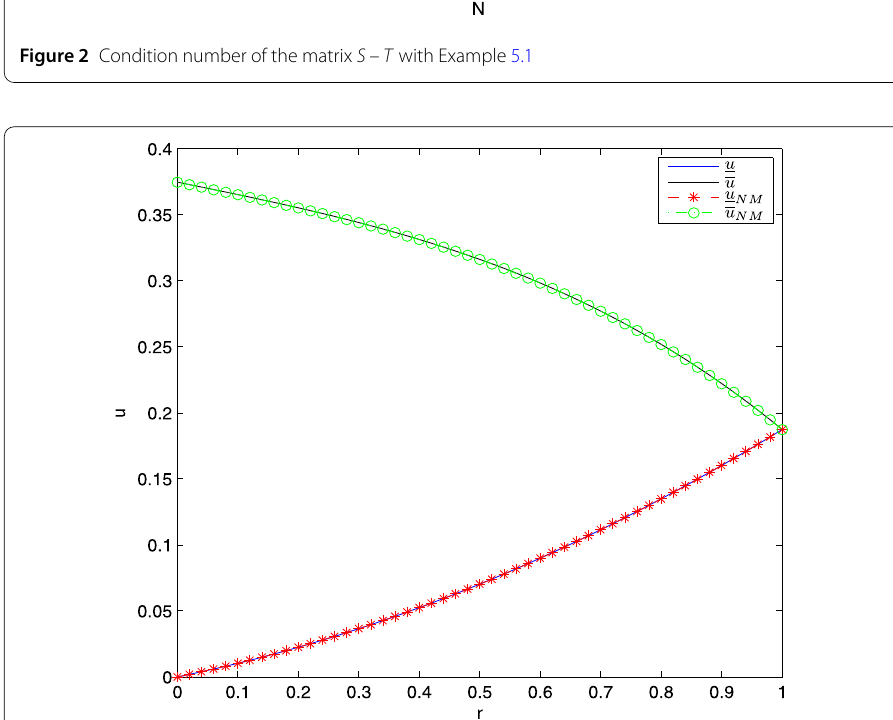
Figure 3 Exact solution and approximate solution with N = 2 of Example